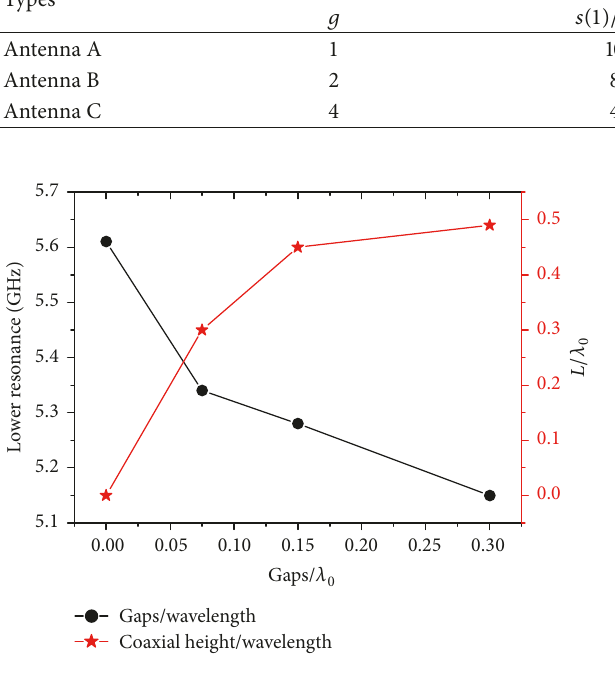
Figure 5: The simulated height 𝐿 and gaps versus lower resonance.